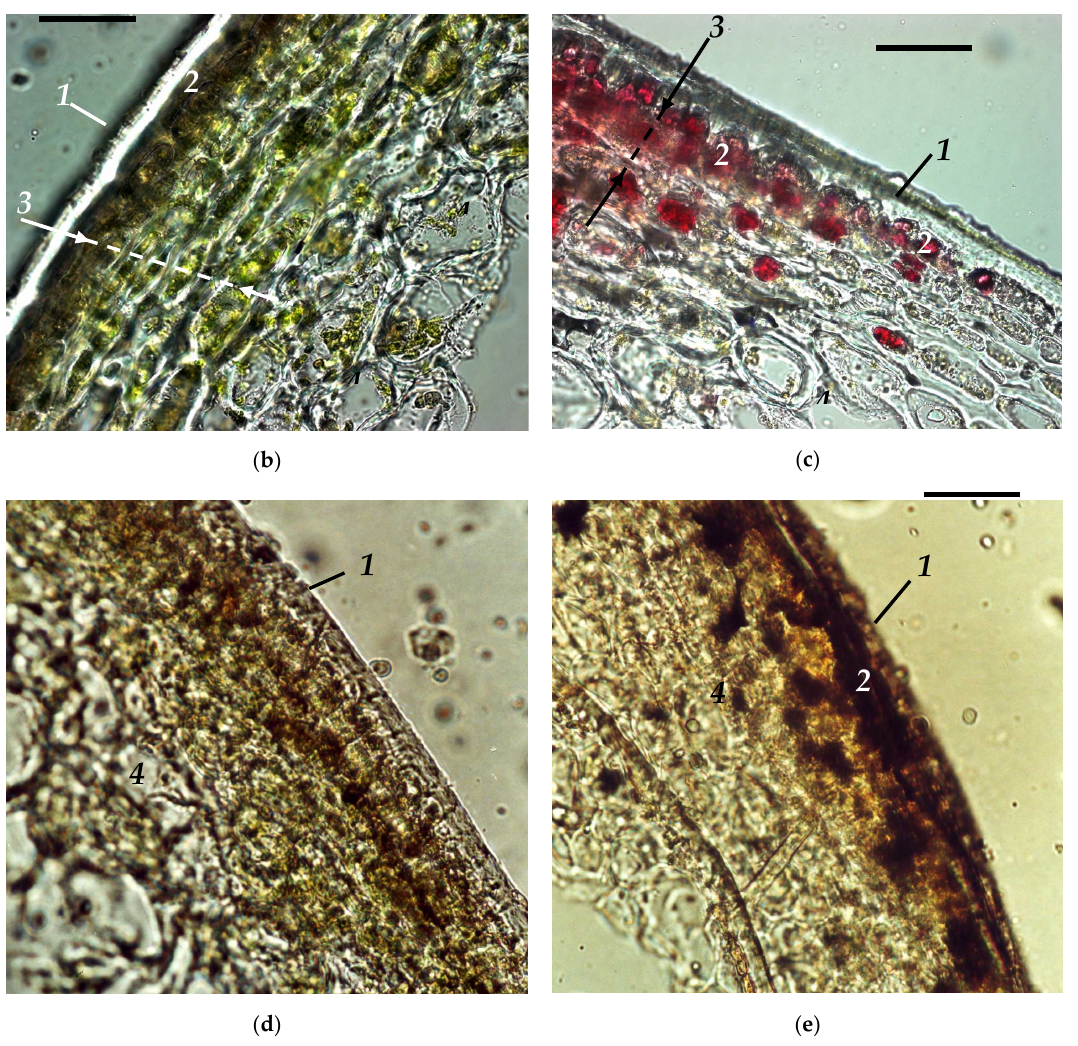
Figure 1. Visual appearance ( a ), anatomy and morphology of healthy ( b , c ) green ( b ) and red ( c ) apple fruit as well as fruit affected by ( d ) mild sunscald and ( e ) severe cell necrosis due to scab. In panel (a), the fruit surface regions corresponding to the micrographs (b–e) are shown. 1 —cuticle, 2 —epiderm, 3 —pigment-enriched compact “peel” (outer mesocarp), 4 —highly reflective “pulp” (inner mesocarp). The images were taken using Zeiss Axioscope photomicroscope at a magnification of × 200. Scale bar: 50 µ m. Table 1. Average pigment content of the apple fruits studied in this work. Pigment